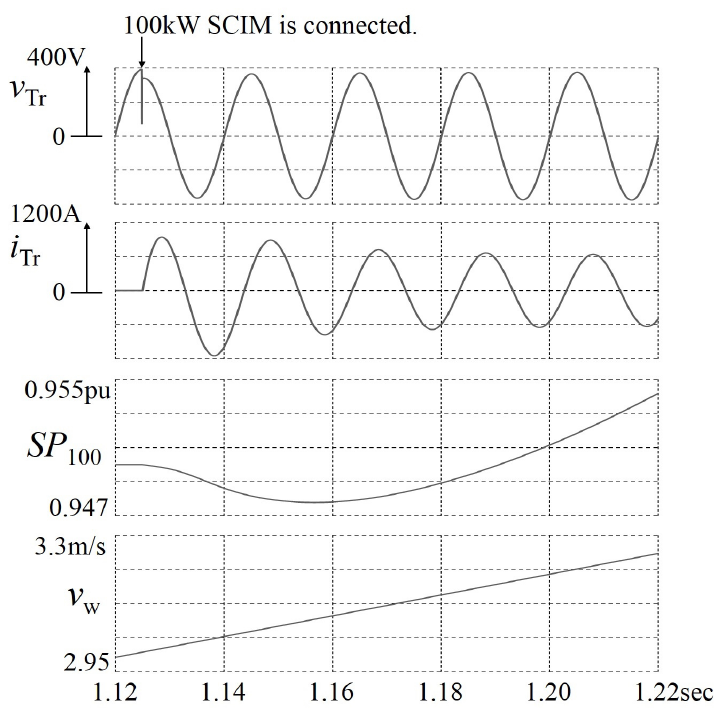
Figure 4. Simulated waveforms of the direct connection for the 100-kW SCIM.